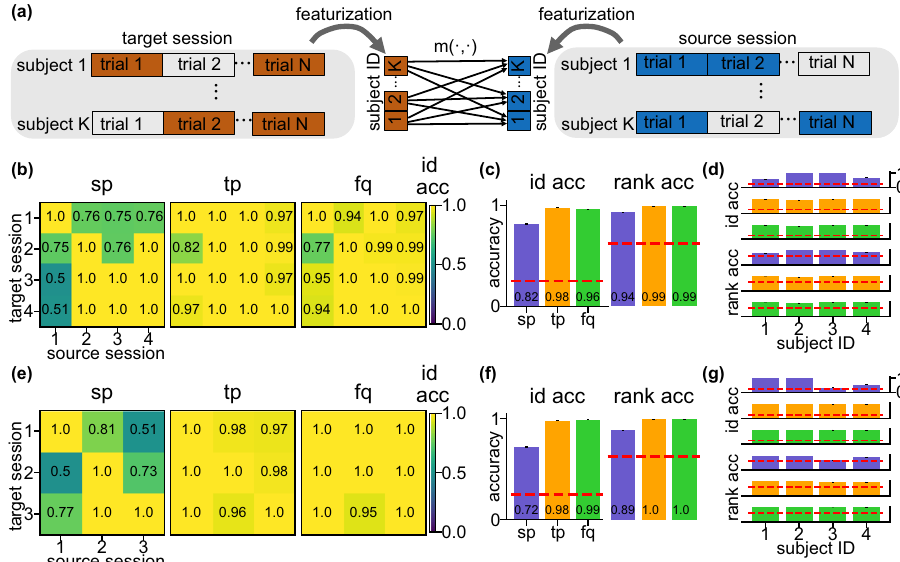
Fig. 4 Cross-session identi fi cation on FST and SEN data con fi rms existence of brainprints. a Schema of the cross-session identi fi cation task. For one identi fi cation run, the features of each individual are computed using randomly sampled trials ( N = 300) from both the source and target session. Target session features are then classi fi ed by selecting the individual with the largest similarity score in the source session. b Heat maps of the cross-session identi fi cation accuracy using the three features on FST data. Each grid represents the average accuracy across 4 individuals and 100 identi fi cation runs. The within-session accuracy (diagonal entries) are computed using the same source-target splitting procedure as on the Harry Potter data to avoid data leakage. c Average cross-session identi fi cation accuracy and rank accuracy for each feature on FST data. Within-session accuracy (diagonal entries in b ) were excluded in computation. Error bars are the SEs across cross-sessions ( N = 12), individuals ( N = 4), and identi fi cation runs ( N = 100) and are invisible due to small values. Red dashed lines are the chance level for the identi fi cation accuracy ( = 0.25) and rank accuracy ( = 0.625). d Identi fi cation and rank accuracy on FST data by individual. Within-session accuracy were excluded in computation. Error bars are the SEs across cross-sessions ( N = 12) and and identi fi cation runs ( N = 100) and are invisible due to small values. The red dashed lines are the same as in ( c ). e – g Same as ( b – d ) but on SEN data with the same number of individuals and identi fi cation runs ( N = 4 and N = 100) but different number of cross-sessions ( N = 6). The high identi fi cation accuracy with the three features on multi-session datasets con fi rms these features can be brainprints for individual identi fi cation.